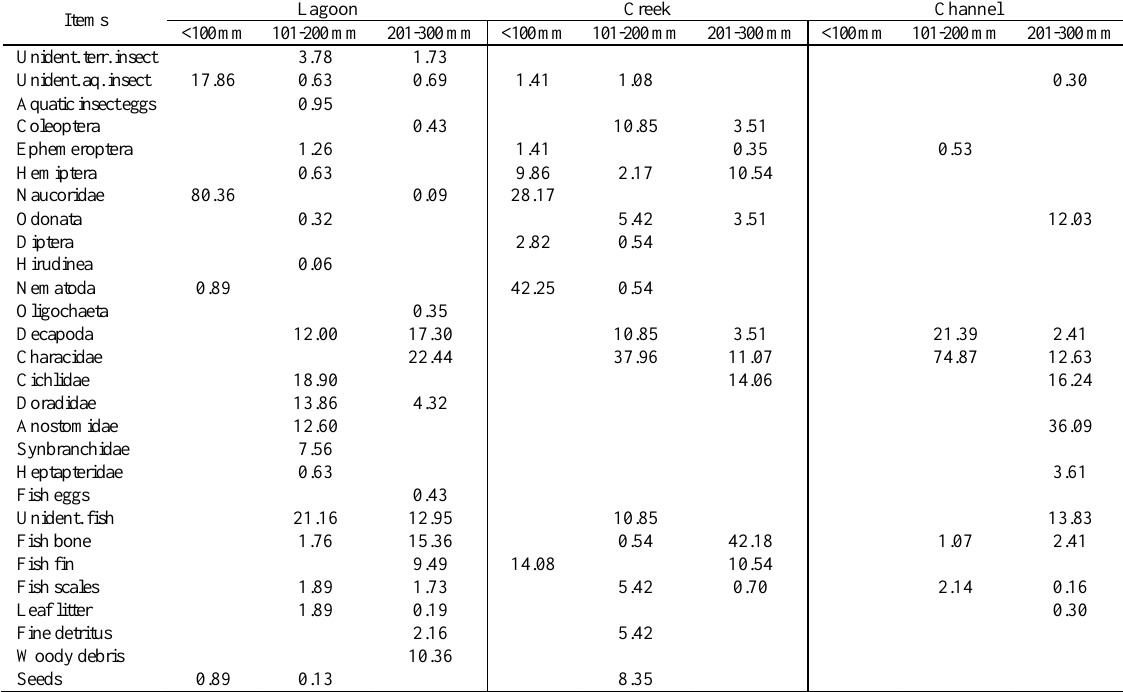
Table 1. Volumetric percentages of dominant food resource categories consumed by size classes of C . lugubris in three habitats of Cinaruco River. Number of stomachs with prey items: Lagoon (n = 35), creek (n = 17), Channel (n = 22).